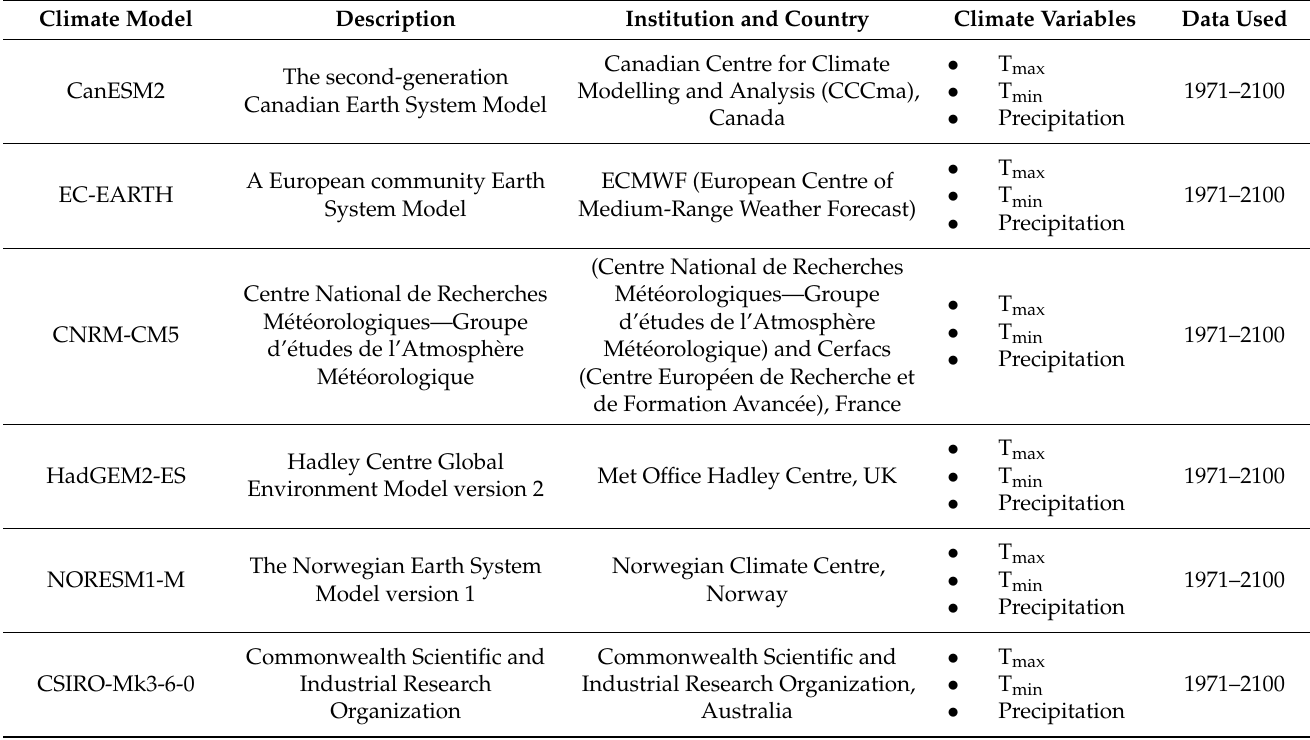
Table 2. Climate models with their description, climate variables, and data